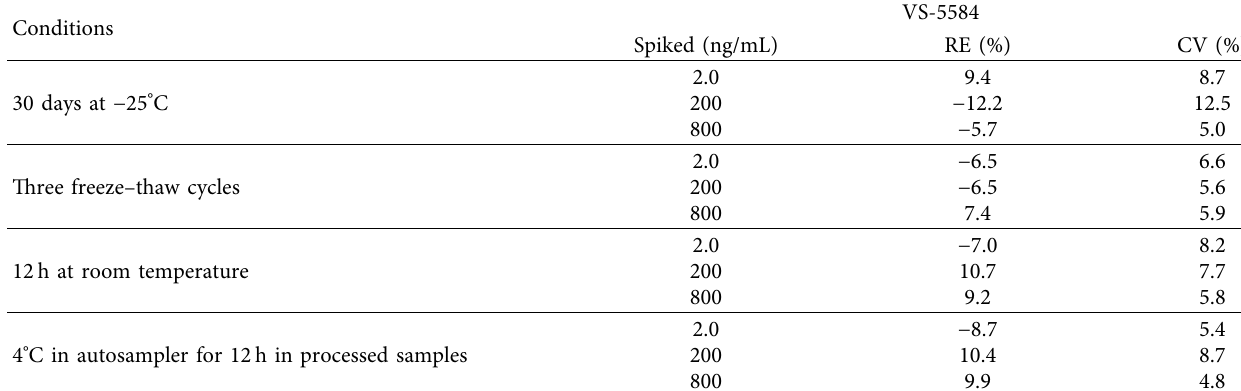
Table 2: Stability of VS-5584 in rat plasma ( n � 3).